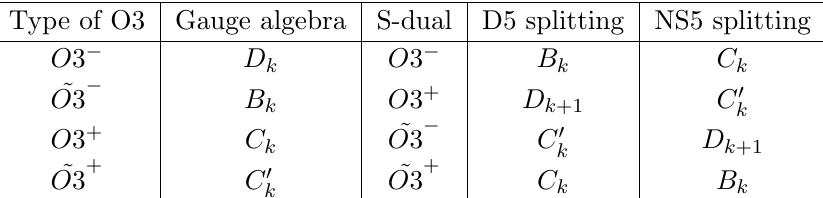
table 2. In order to compute the mirror theory, we also need to keep track of brane creation